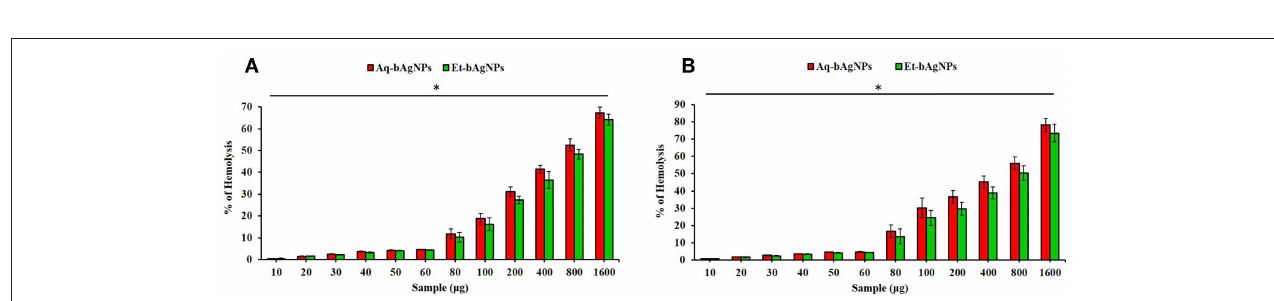
FIGURE 5 | Lipid peroxidation assay. The cell membrane fatty acid oxidation potential of biogenic silver nanoparticles was measured through MDA–TBA adduct assay. The absorbance of MDA–TBA pink adduct was measured at 532nm (i.e., λ max ). The values presented are mean ± SE of multiple samples ( n = 3). Data were analyzed using one-way ANOVA followed by Tukey’s multiple comparison test. The absorbance of MDA–TBA adduct of bAgNPs treated bacteria were significantly higher than that of the untreated bacteria (i.e., control) and * P < 0.01.